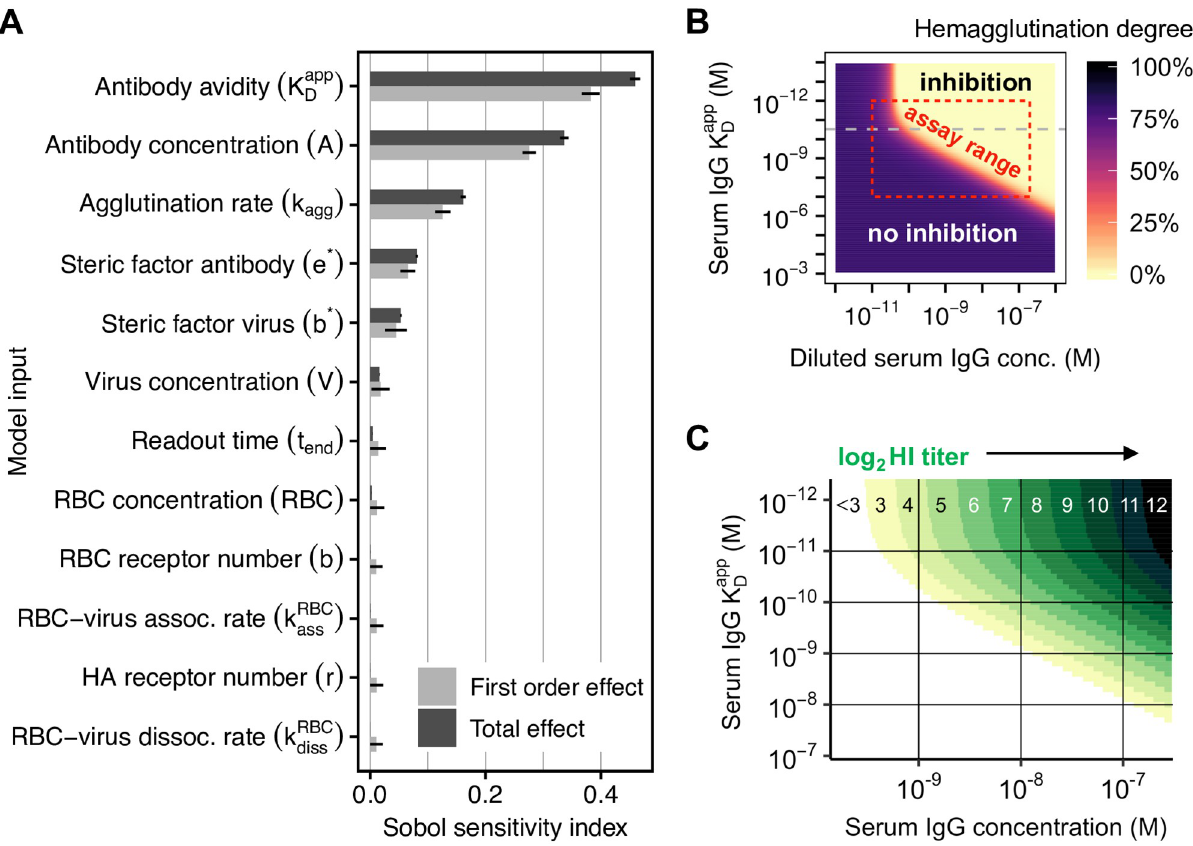
Fig 2. Model sensitivity and resolution of the hemagglutination inhibition assay for influenza H1N1pdm09. ( A ) Sensitivity analysis using Sobol indices. First-order effects show only the linear contribution to the total variance in hemagglutination degree (they sum up to 1), whereas total effects consider also interactions (see Methods for details). ( B ) Predicted degree of hemagglutination for different IgG concentrations and apparent dissociation constants K app . The red box indicates the usual assay range, bounded by the biological range of K app D dashed line indicates K app ¼ 0 : 03 nM . ( C ) Predicted HI titers for the biological range of influenza-specific serum IgG and K app D correspond to titers shown on top.